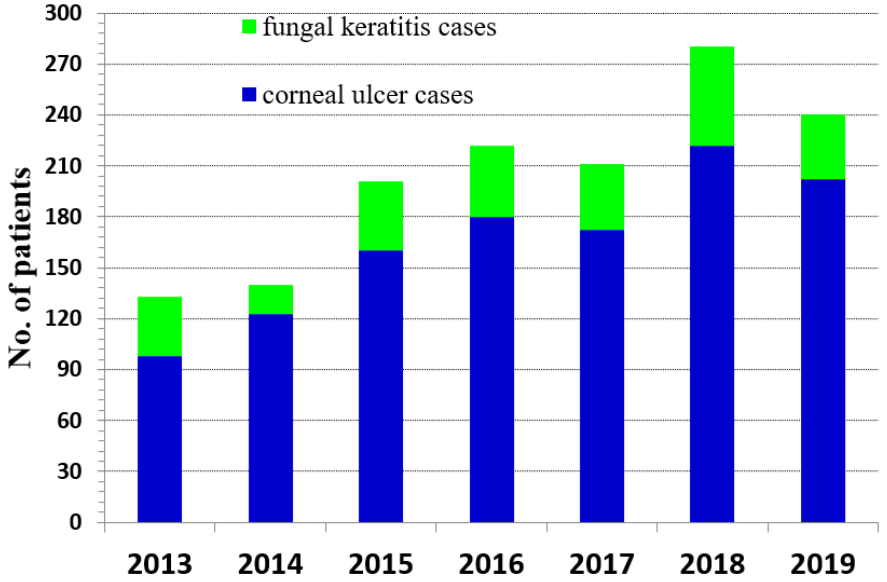
Figure 3. Number of patients with confirmed fungal keratitis compared to patients with other causes of corneal ulcers from 2013 to 2019.